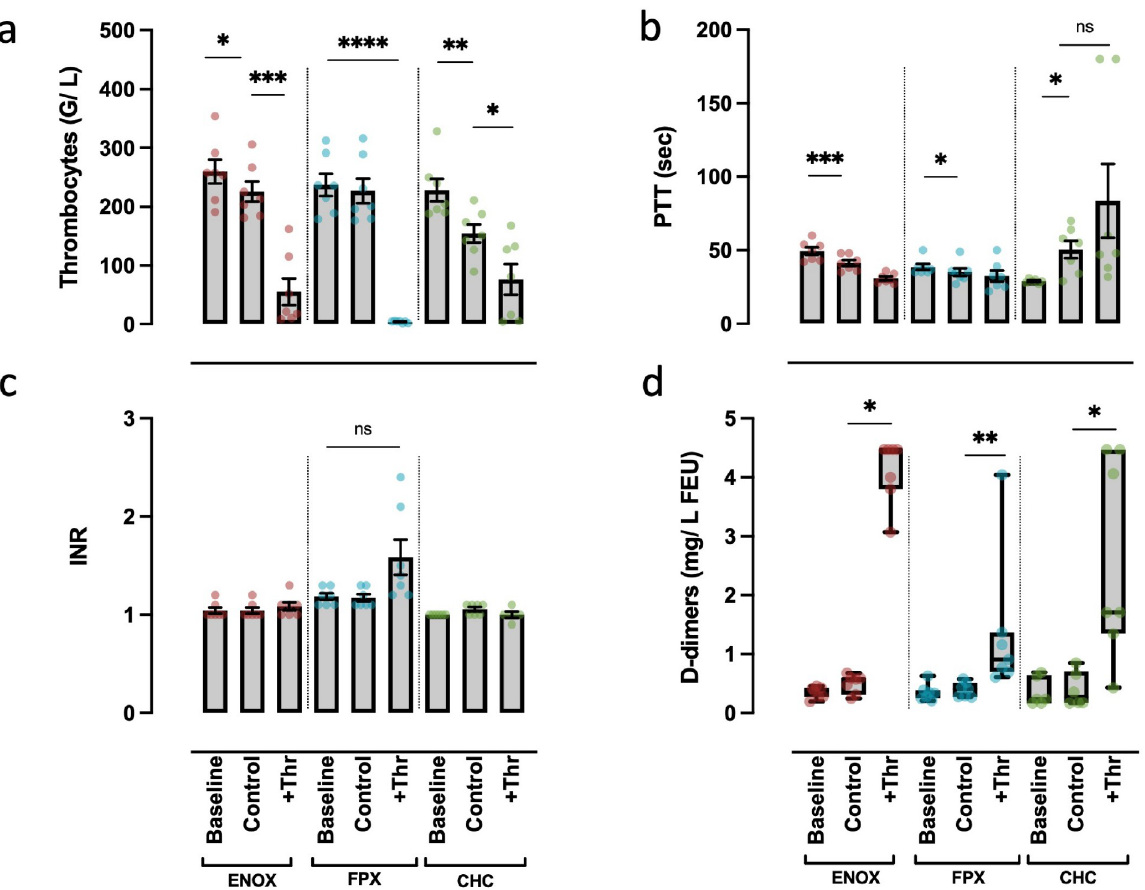
Fig 1. Laboratory parameters of plasmatic and cellular coagulation in three different thrombin-activated models. Thrombocyte counts (a), PTT (b), INR (c) and d-dimers (d) were measured. For each experiment, samples were taken both directly after blood-drawing (Baseline) and after 30 min of incubation without (Control) and with 1 U/mL Thrombin (+Thr). Each experiment was performed with either CHC coating or MPC coating plus anticoagulation with either enoxaparin (ENOX) or fondaparinux (FPX). For statistical analysis, each group (FPX, ENOX, CHC) was tested separately. RM one-way ANOVA with Geisser-Greenhouse correction with Dunnett’s post-hoc test (a-c) and Kruskal-Wallis test with Dunn’s correction (d) were performed. � p < 0.05; �� p < 0.01; ��� p < 0.001; ���� p < 0.0001; ns: Not significant. Values presented as mean ± s.e.m (a, b, c) and median ± range (d). All samples: n = 7, except for CHC baseline (b, c), CHC Control (d): n = 6; CHC +Thr (c): n = 5, due to technical reasons (b, c) and exclusion of an outlier (d: 3.37 mg/ L